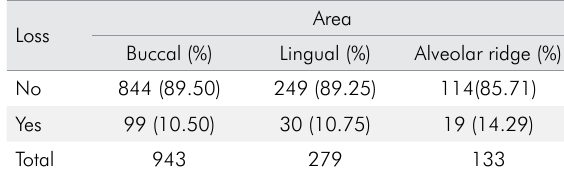
Table 9. MSI loss of stability according to